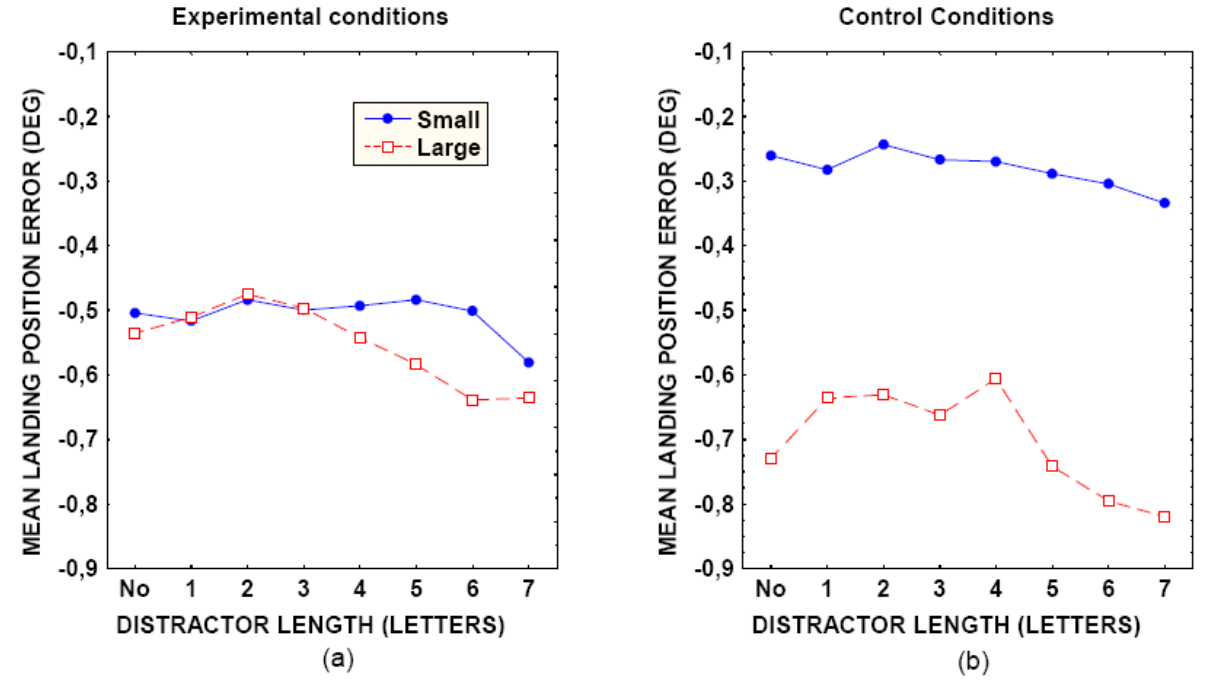
Figure 3. Mean landing position error (in degrees) of the initial saccade made towards the isolated target letter in the character-size experiment, as a function of the length of the distractor string (in number of letters) and the angular size of the characters (small vs. large) in both the experimental (a) and the control (b)